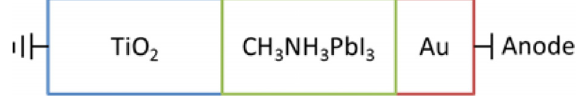
Fig. 3. Circuit used for Mott-Schottky capacitance analysis.